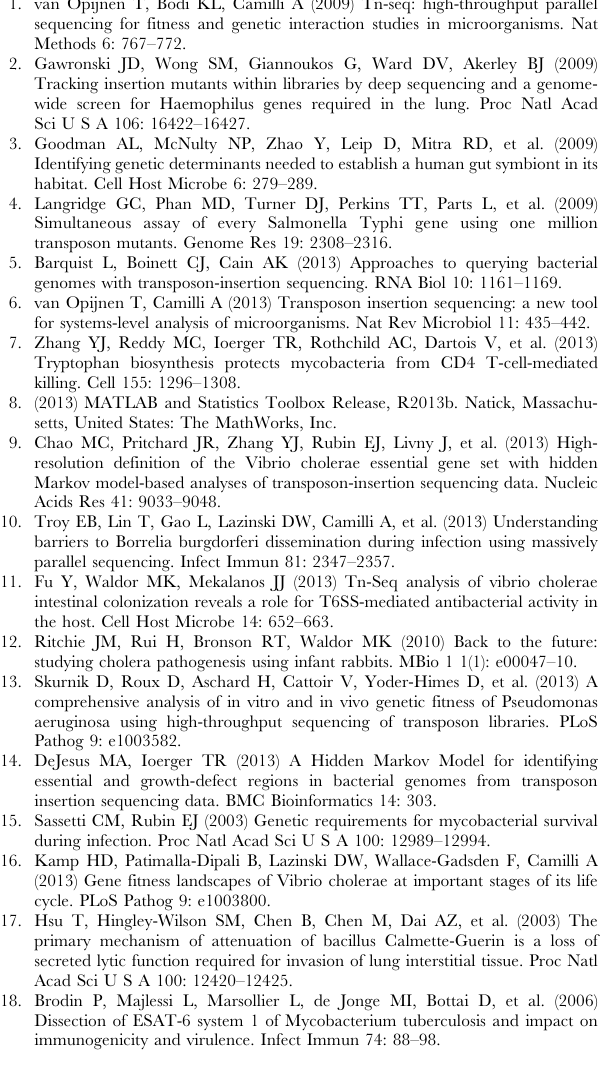
instructions to carry out transposon-insertion sequencing analysis using the ARTIST